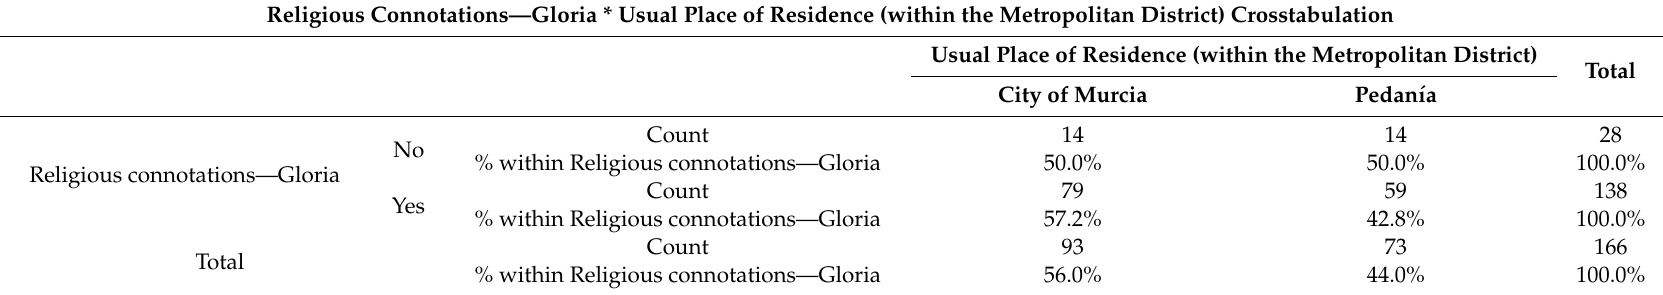
Table 11. Religious connotations in terms of usual place of residence for the name Gloria in the metropolitan district of Murcia. Religious Connotations—Gloria * Usual Place of Residence (within the Metropolitan District)